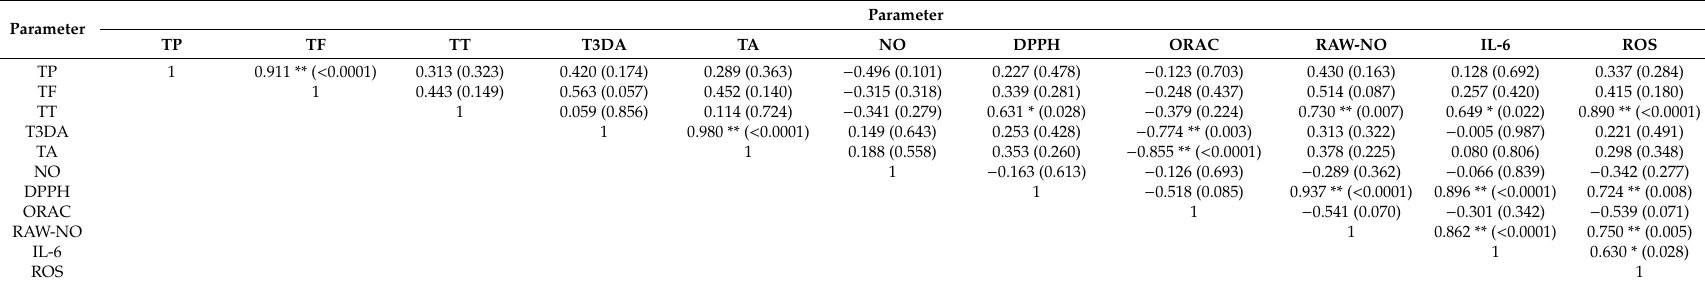
Table 3. Pearson correlation, r, among bioactive concentrations, antioxidant capacity and inhibition of pro-inflammatory markers of sorghum extracts.